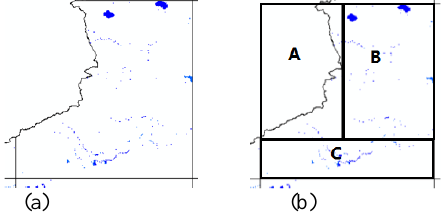
Figure 5 Demonstration of Dynamic Matrix decomposition for zonal statistics. (a) is the area before the decomposition and (b) shows that after decomposition (A, B and C marks the different